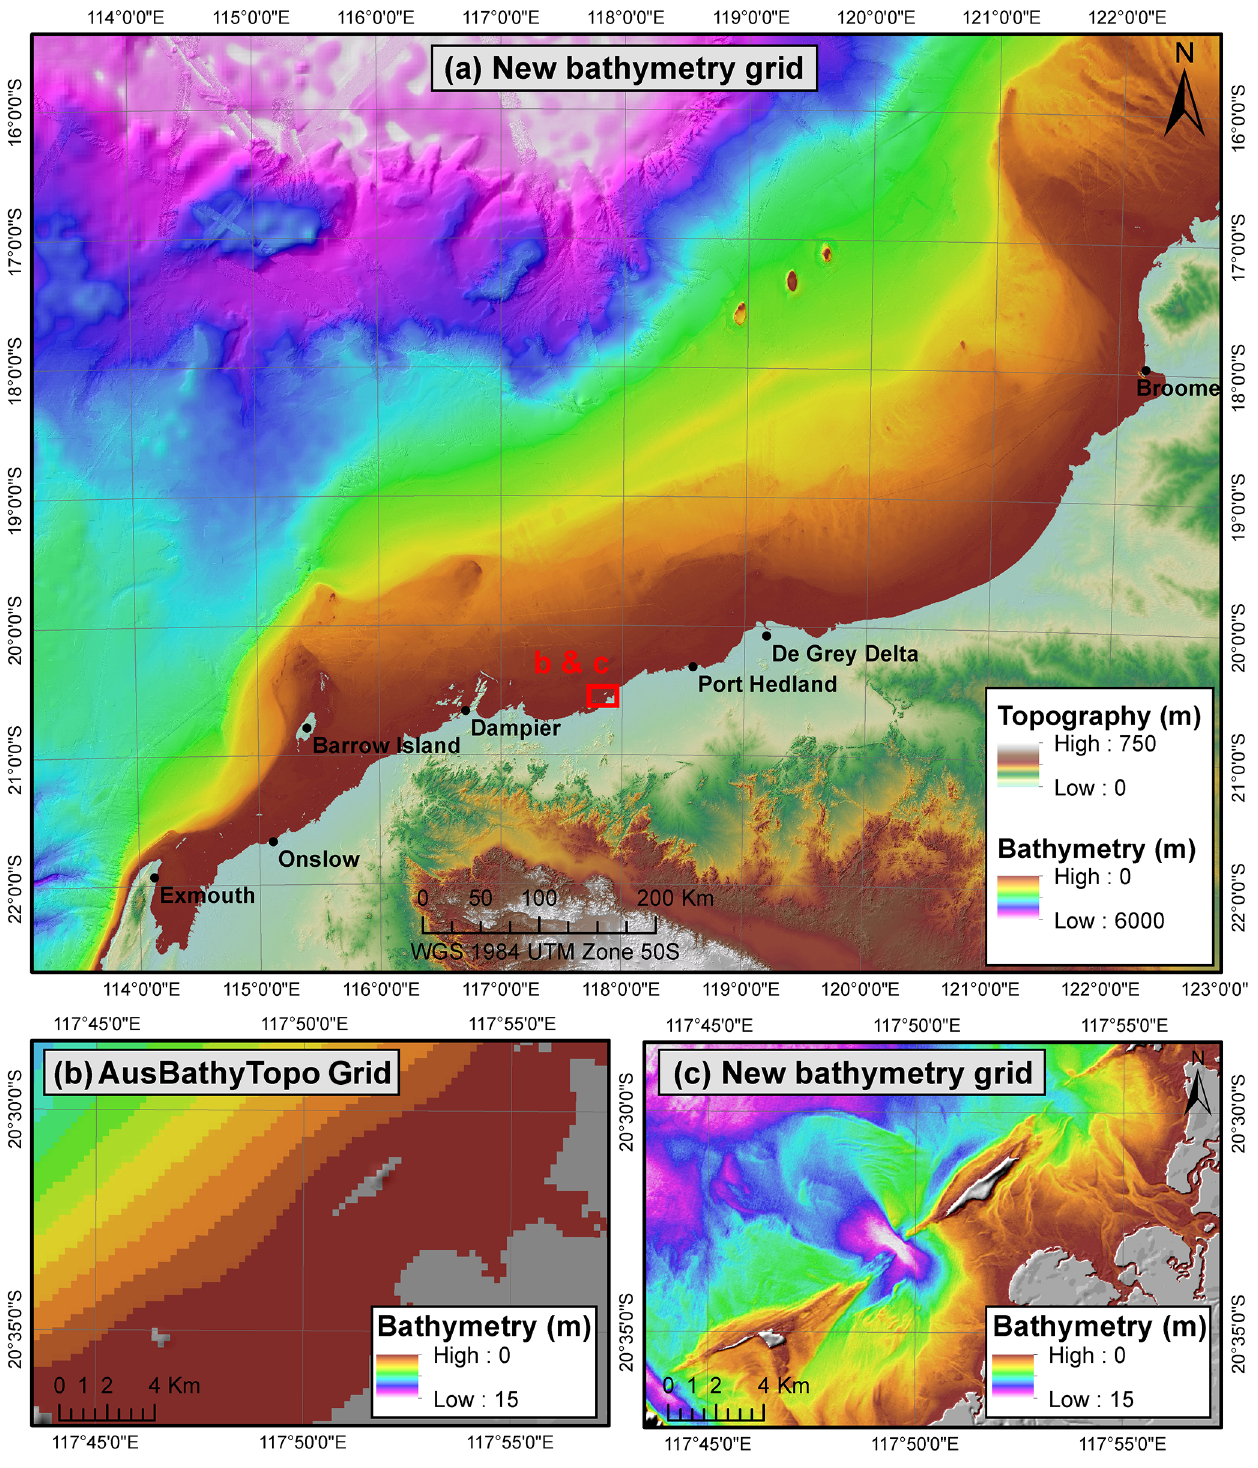
Figure 14. Overview of the produced DEM. Panel (a) displays the new bathymetry grid produced from the integration of the seismic-derived bathymetry, satellite-derived bathymetry, MBES bathymetry (from GA and reprocessed), and SRTM topography. Gaps are filled with the 9arcsec Australian Bathymetry and Topography Grid. The compilation is a major upgrade of the pre-existing regional data (e.g. panel b vs. panel c ). For data sources, see Sects. 3, 4.2.1, 4.3.1, and 5.2.1.